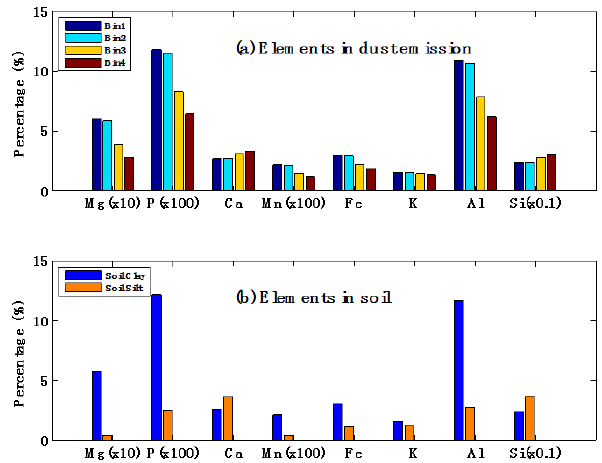
Figure 3. Global mean elemental percentages in (a) four-bin dust emission and (b) clay and silt fractions of soils (bins 1–4 refer to particle range listed in Table S2, clay refers to <2µm, silt refers to